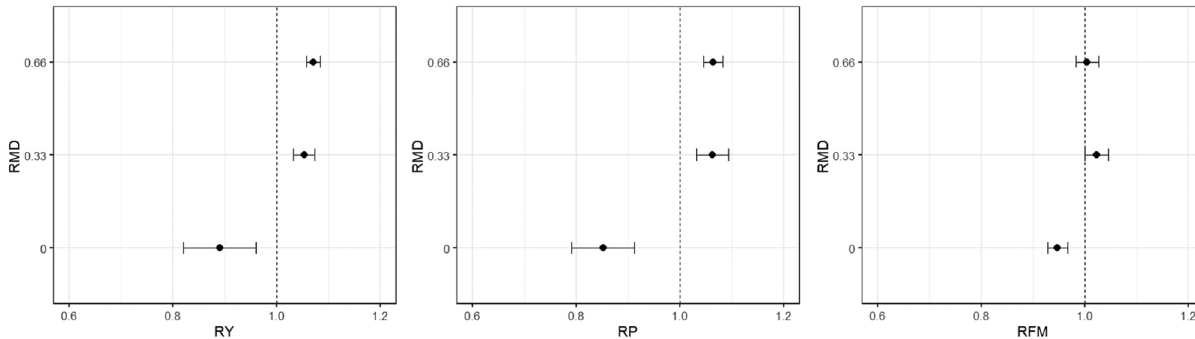
Figure 3: The overall e ff ect of RY, RP, and RFM responding to RFCD of tobacco.